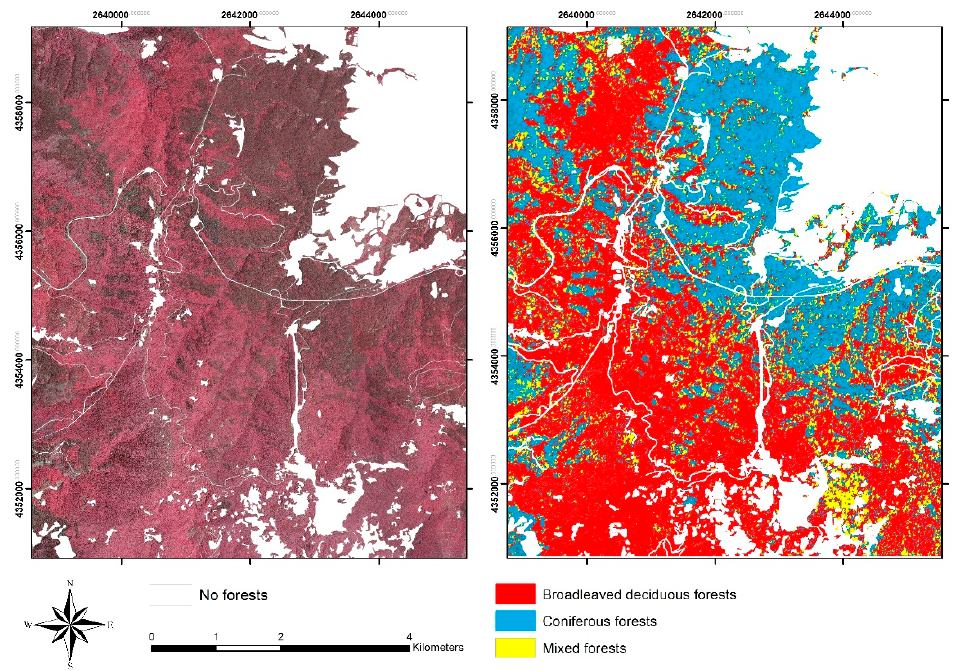
Figure 4. On the left, VHR aerial image (infrared false color) of the study area where “no forest” is highlighted in white and on the right, the map of forest areas covered by coniferous, broadleaves and mixed stands (EPSG 3004).